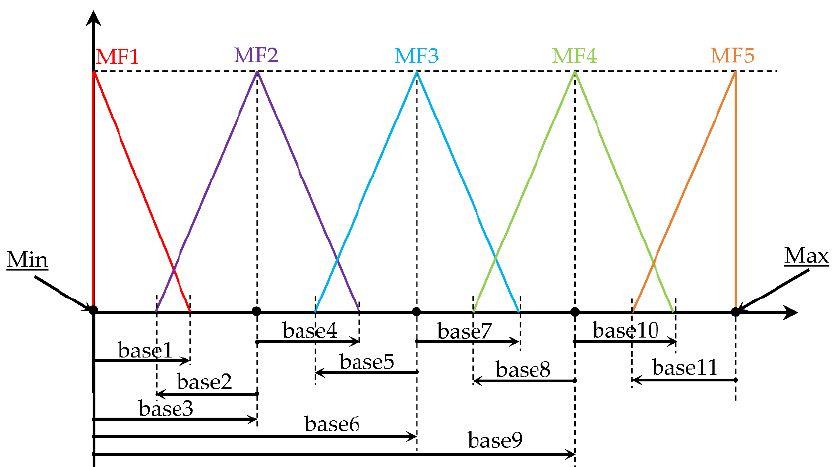
Figure 8. The schema of the genetic algorithm cycle.